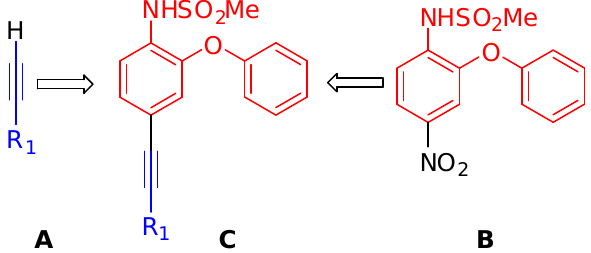
Figure 1. Design of hybrid molecule C from alkyne A and nimesulide B